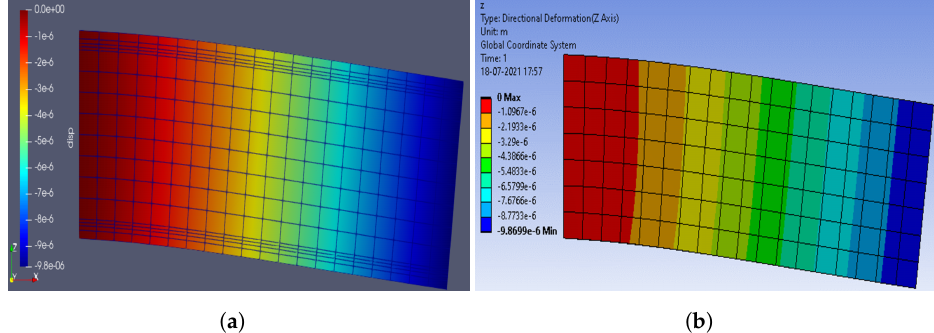
Figure 5. One side fixed beam, submitted to self weigth. ( a ) Paraview (Python), ( b ) ANSYS.